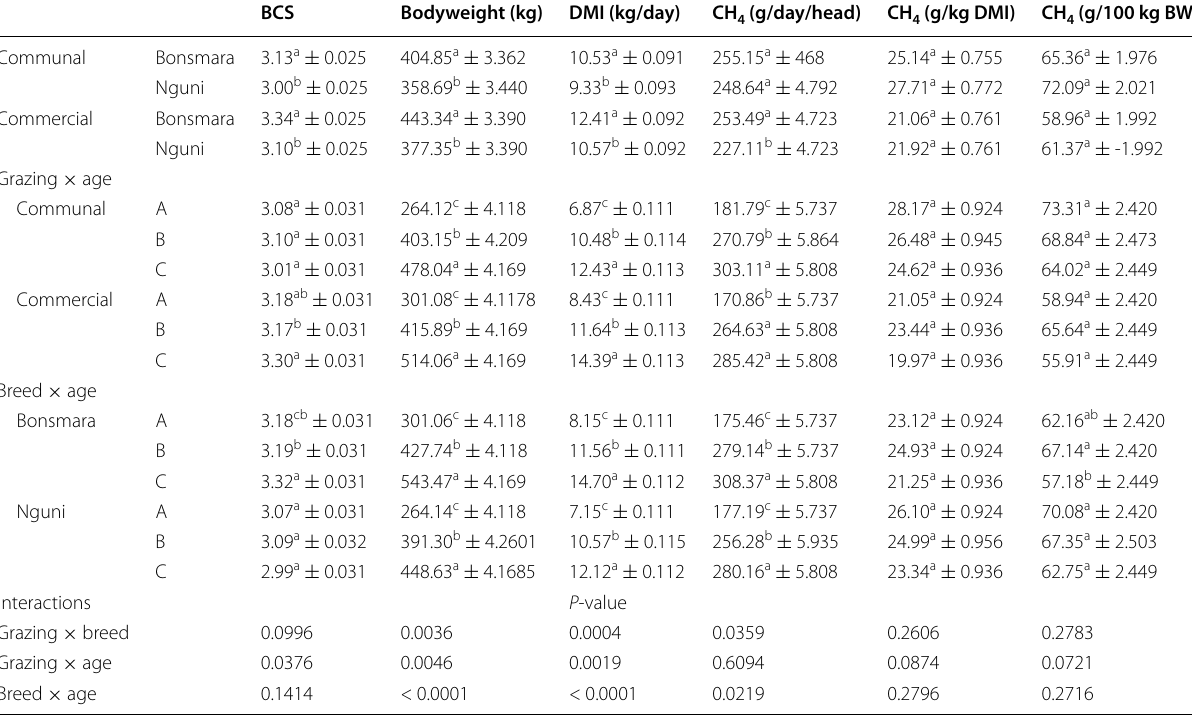
Table 5 Means ( SEM) of methane production and other performance parameters as affected by the interaction ±